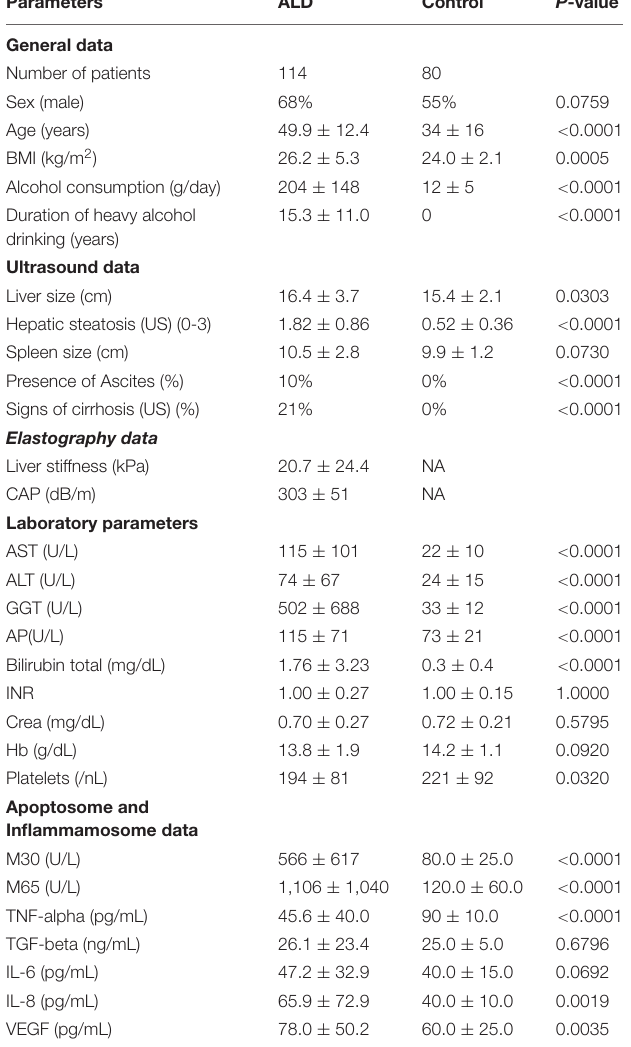
TABLE 1 | Patient